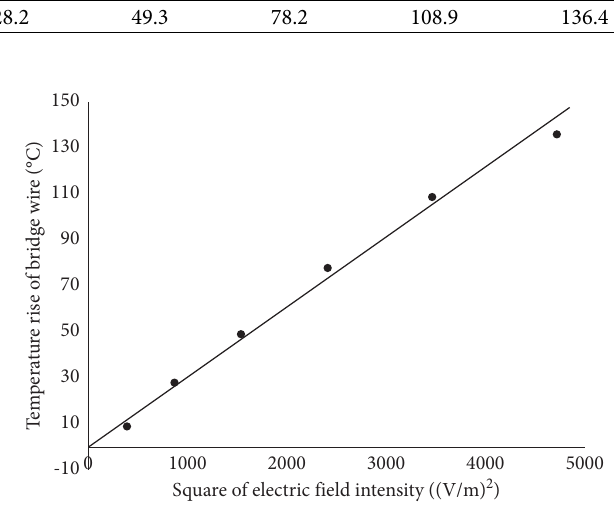
Figure 8: Relationship between the temperature increase of bridge wire and square of electric field intensity at